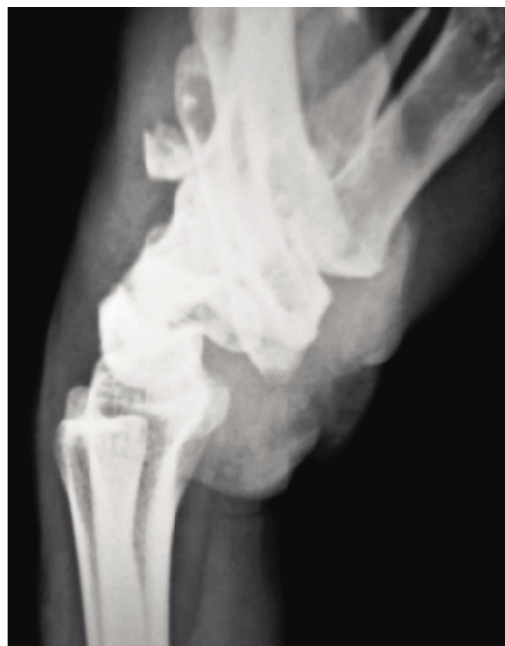
Lateral radiograph view showing Classification Type C.1. Fig. 4: Divergent dislocations of multiple metacarpals with concomitant metacarpal shaft